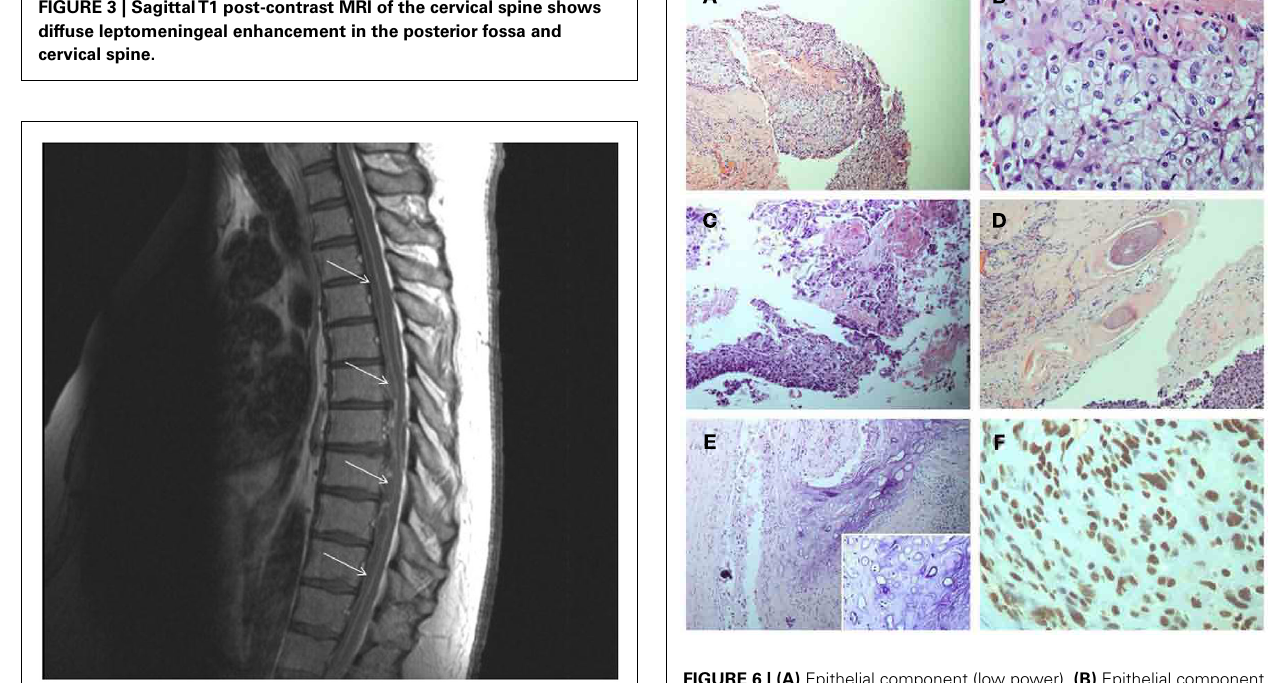
FIGURE 6 | (A) Epithelial component (low power). (B) Epithelial component (high power). (C) . Epithelial component with squamous differentiation (low power). (D) Hair follicle component (low power). (E) Mesenchymal/ cartilaginous component (low power; insert: high power). (F) p63 immunoperoxidase staining of the epithelial component (high